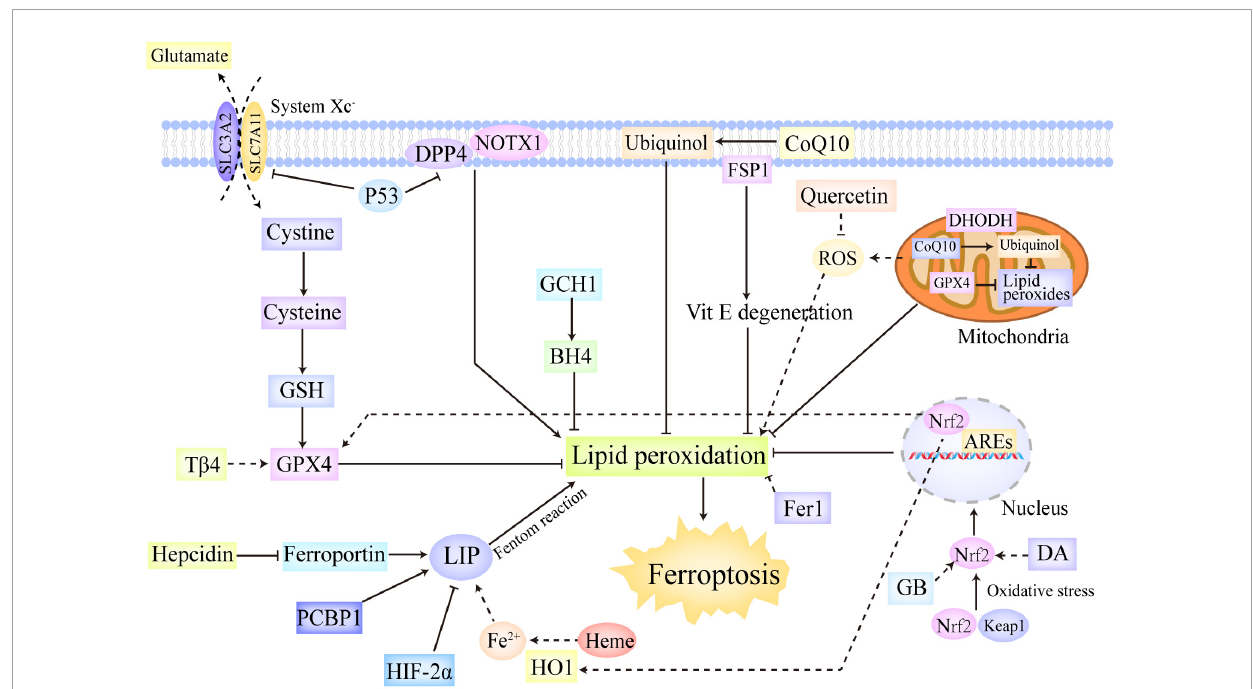
FIGURE2 The regulation systems involved in ferroptosis. Ferroptotic cascades are under sophisticated and multifaceted regulation. The system Xc - /GSH/GPX4 axis reduces toxic lipid peroxides to non-toxic alcohols, thus markedly downregulating lipid peroxidation. The FSP1/CoQ axis can reduce CoQ10 to ubiquinol and regenerate Vitamin E, which confer protection against free radical insults and lipid toxicity. The GCH1/BH4 axis not only exerts direct antioxidant effects but also regulates the synthesis of CoQ10, thereby inhibiting lipid peroxidation and ferroptosis. In addition, mitochondrial GPX4 and DHODH were also found to represent two additional defensive enzymes against ferroptosis via the detoxification of lipid peroxides in the mitochondria. Moreover, P53 and Nrf2 are identified as two significant transcriptional factors in ferroptosis regulation. P53 not only can trigger ferroptosis by downregulating SLC7A11, but also can repress ferroptosis by combining with DPP4, which interacts with NOX1 on cellular membrane and leads to lipid peroxidation without P53. Oxidative stress initiates the release of Nrf2 from Keap1, thus activating Nrf2. The activated Nrf2 is then translocated into the nucleus in which it can regulate the transcription of the genes contained AREs, thus conferring protection against oxidative insults. Besides, Nrf2 also participates the regulation of some important genes in ferroptotic cascades, such as HO1 and GPX4. Furthermore, hepcidin, HIF-2 α , HO1, and PCBP1 also take part in ferroptosis regulation by exerting impact on iron metabolism. ARE, antioxidant response element; BH4, tetrahydrobiopterin; CoQ10, ubiquinone; DHODH, dihydroorotate dehydrogenase; DPP4, dipeptidyl peptidase-4; GCH1, GTP cyclohydrolase-1; FSP1, ferroptosis suppressor protein 1; GSH, glutathione; GPX4, glutathione peroxidase 4; HIF, hypoxia-inducible factor; HO1, heme oxygenase 1; Keap1, kelch like epichlorohydrin-related protein-1; SLC7A11, solute carrier family 7 member 11; Nrf2, nuclear